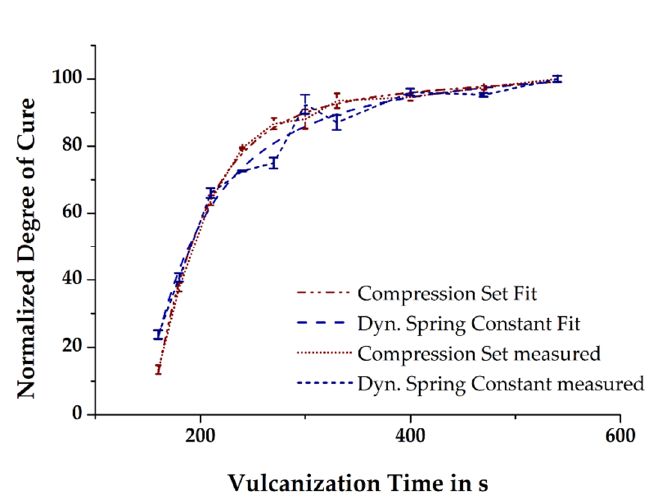
Figure 8. Data fit of normalized relative degree of cure calculated from the compression set (CS) and DMA measurements, respectively.